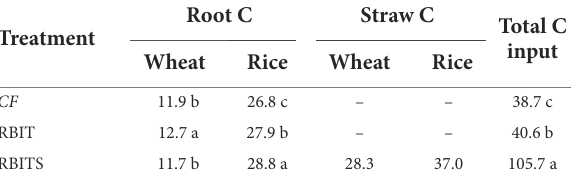
TABLE 1 Estimated 9–year cumulative carbon input for each